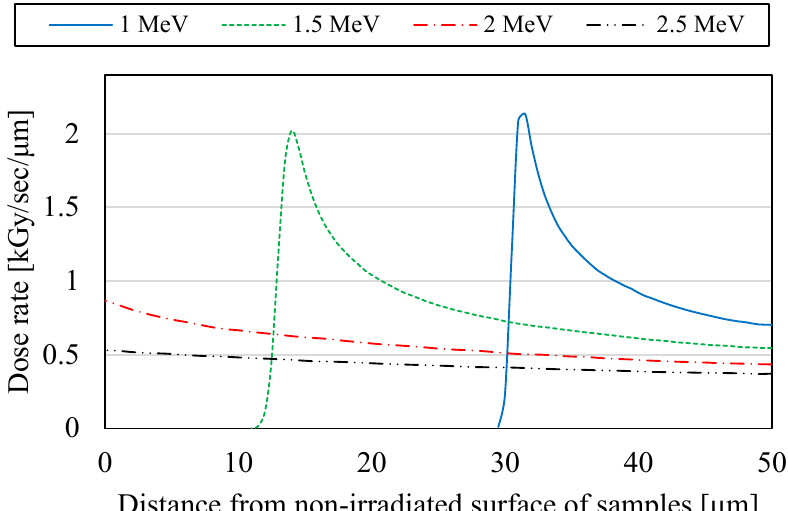
Figure 6. The dose rate distributions of the proton irradiated PI samples calculated using TRIM.